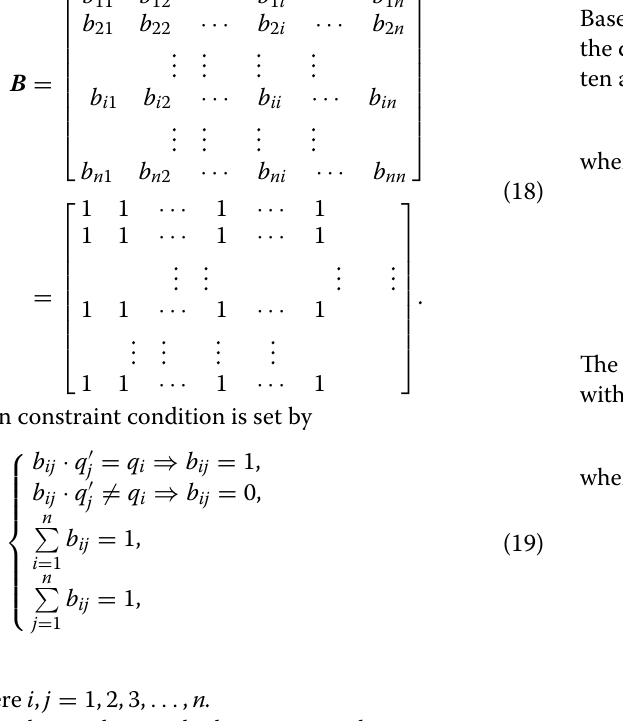
Based on SMM, the rearranged matrix B is obtained, and the dynamics equations of the SLE in this case are rewrit- ten as